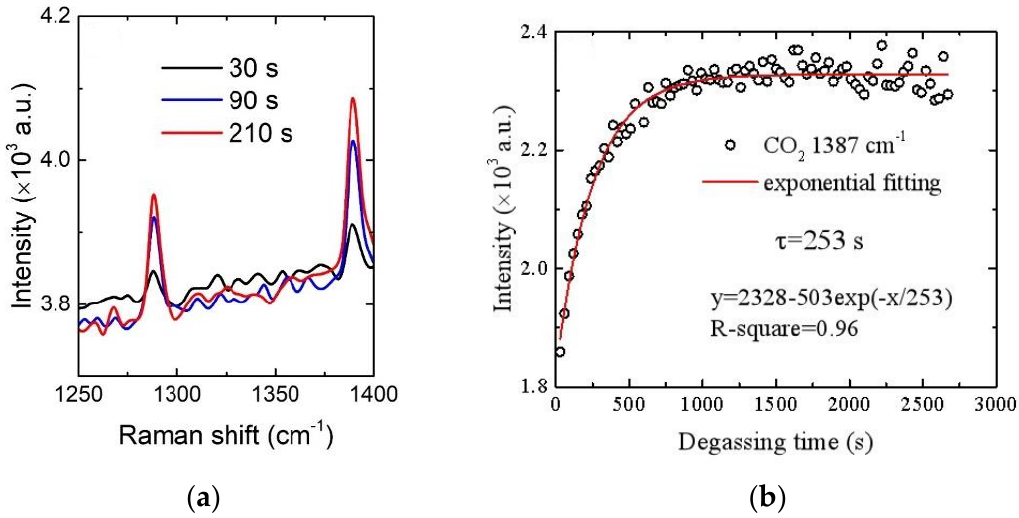
Figure 5. Spectra of different degassing times ( a ) and response curves of CO 2 signal intensity with degassing time ( b ) at 550 mL/min.